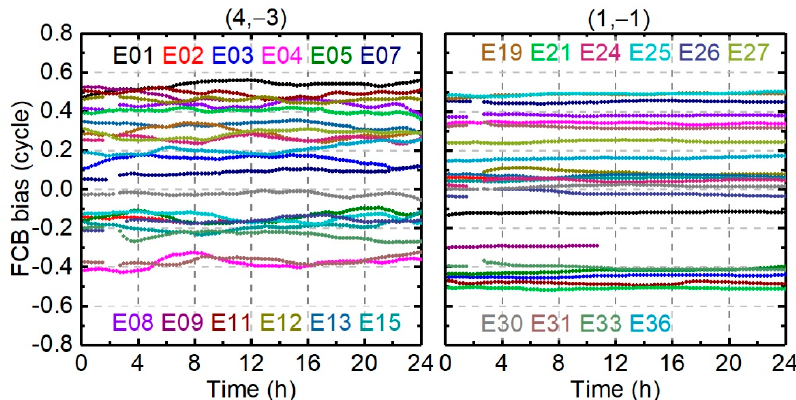
Figure 14. One day (3 September 2019) Galileo FCB time series of the NL and WL combinations.